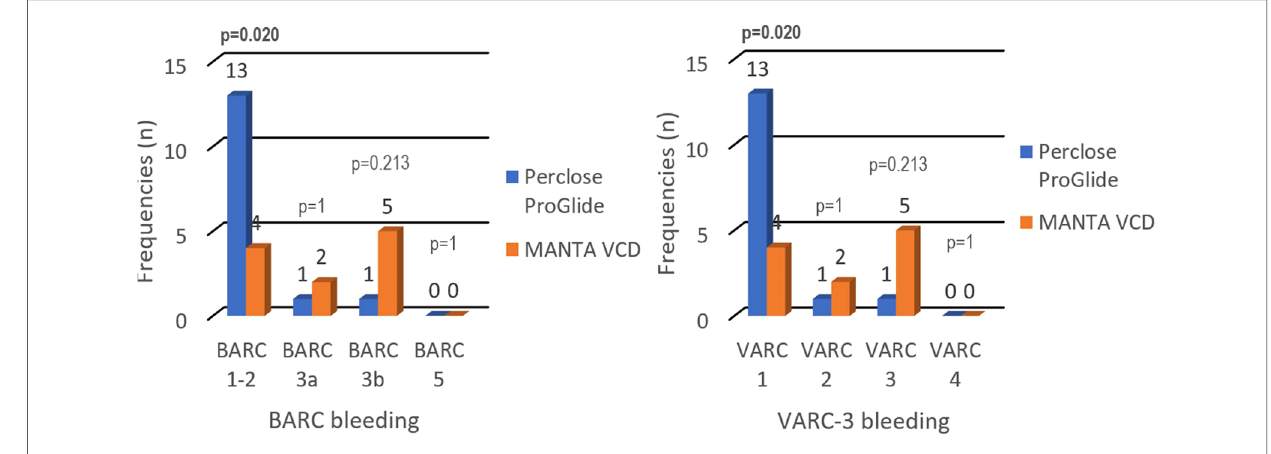
FIGURE 1 BARC and VARC-3 bleeding criteria — Perclose ProGlide vs. MANTA